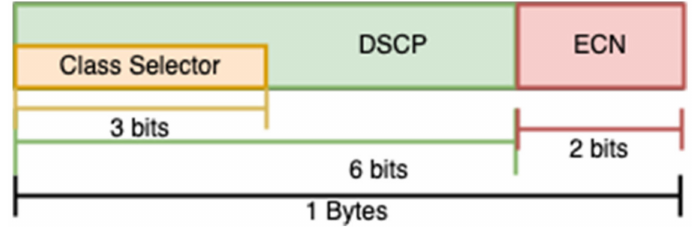
Figure 4. DSCP field